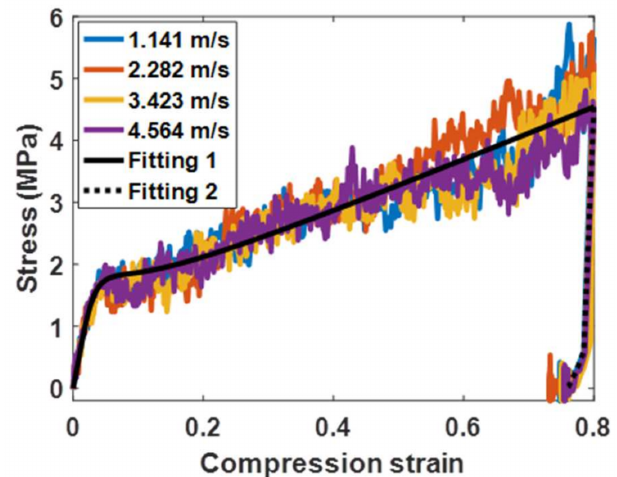
Figure 3. Compression stress as a function of compression strain for the buckypaper with density of 107.6 kg⁄m 3 under different compression